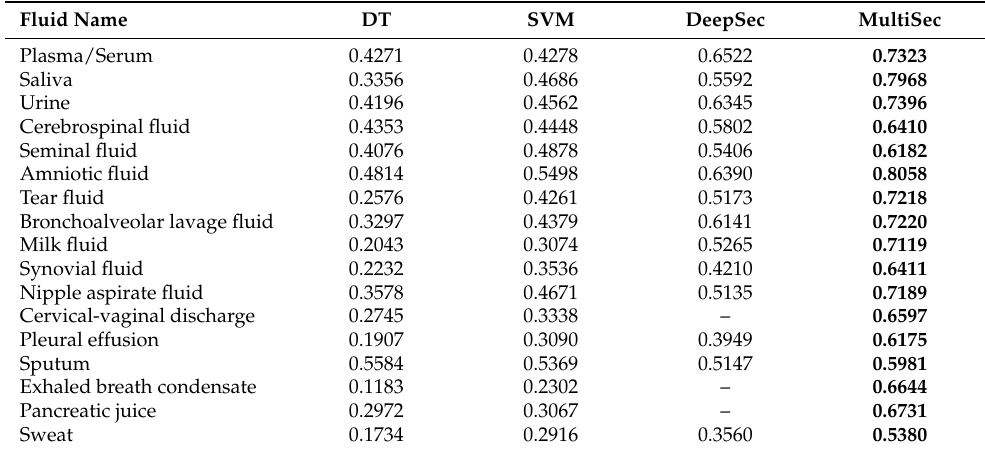
Table A5. MCC benchmarks of MultiSec and compared methods on the independent testing datasets of 17 human body